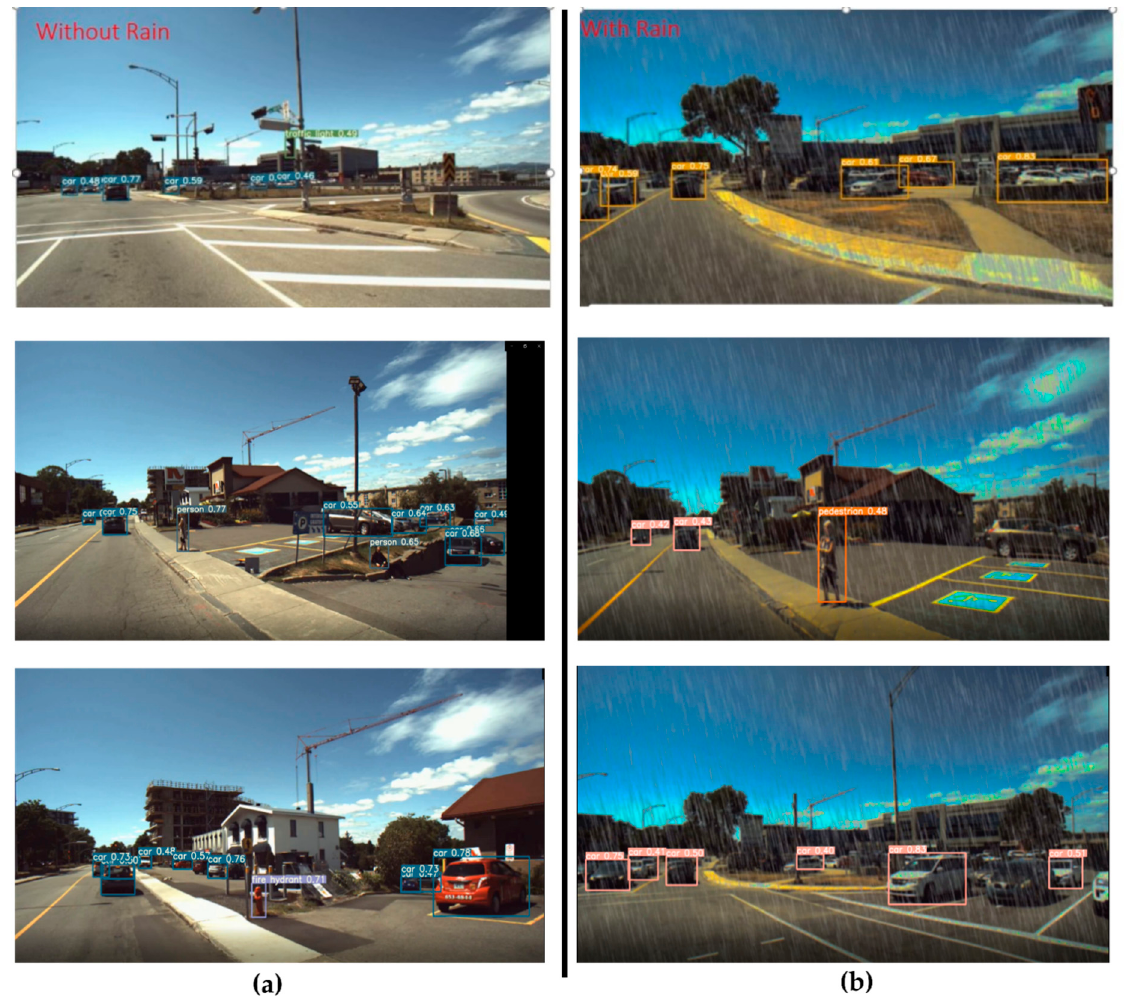
Figure 4. Model verification for two different scenarios: ( a ) without rain and ( b ) with rain.